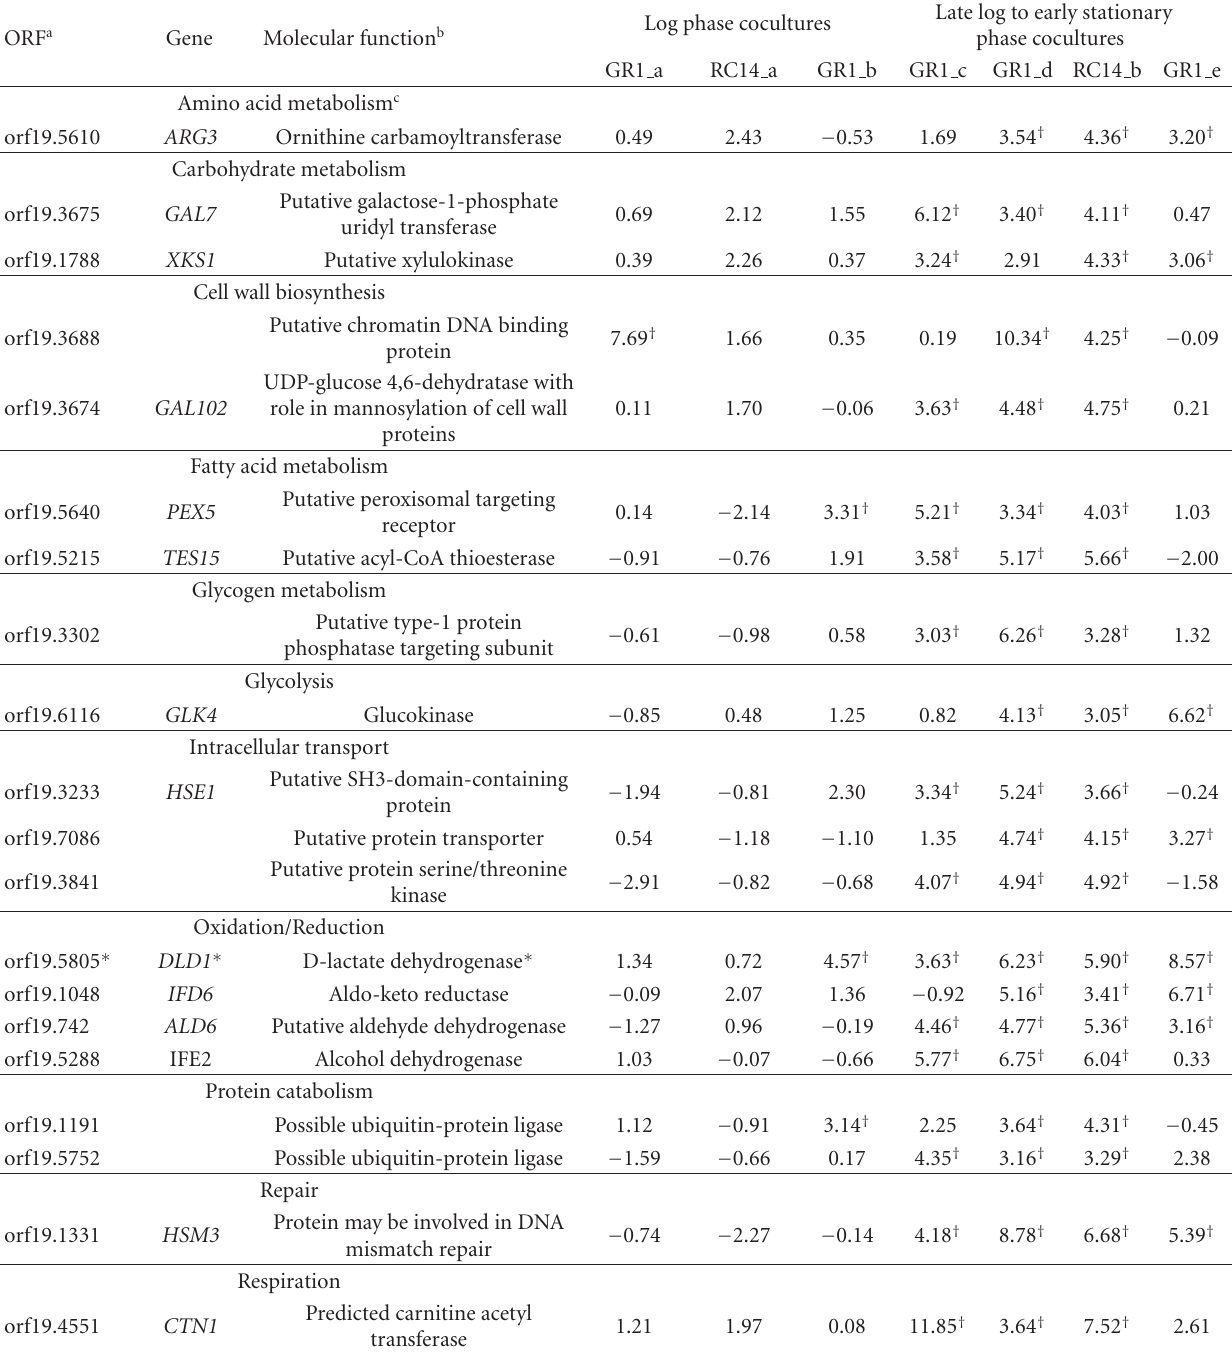
Table 2: Di ff erentially expressed C. albicans genes in cocultures with L. rhamnosus GR-1 or L. reuteri RC-14. Z values for genes with at least three observed incidences of significant di ff erential regulation in the tested conditions are shown. Z -values ≥ 3 and ≤− 3 were considered significant (see Section 2). Values followed by the symbol † indicate gene induction when compared to C. albicans cultures without addition of lactobacilli. Downregulation values are followed by symbol # . Di ff erential gene expression data from coculture experiments with L. rhamnosus GR-1 (GR1 a, b, c, d, e) and L. reuteri RC-14 (RC14 a, b) are grouped according to the C. albicans growth phase (log phase and late log to early stationary phase). Genes are ordered in functional groupings adapted from gene ontology (GO) annotations shown in the Candida Genome Database (http://www.candidagenome.org/). Di ff erentially expressed genes are also divided into upregulated